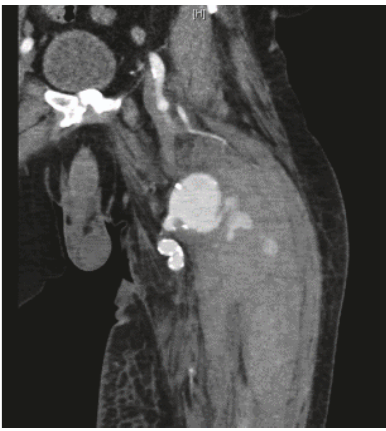
Figure 2: CTA of left lower extremity, coronal images showing the anastomosis pseudoaneurysm with active extravasation.